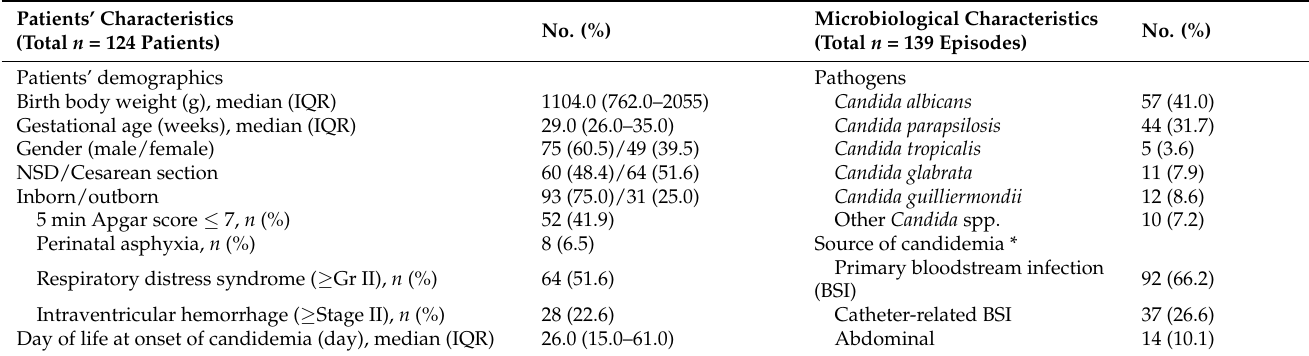
Table 1. Patients’ demographics, microbiological characteristics, clinical features, and outcomes of 124 neonates with 139 episodes of candidemia in the neonatal intensive care unit of CGMH, 2003–2020. Patients’ Characteristics Microbiological Characteristics No. (%) No. (%) (Total n = 124 Patients) (Total n = 139 Episodes) Patients’